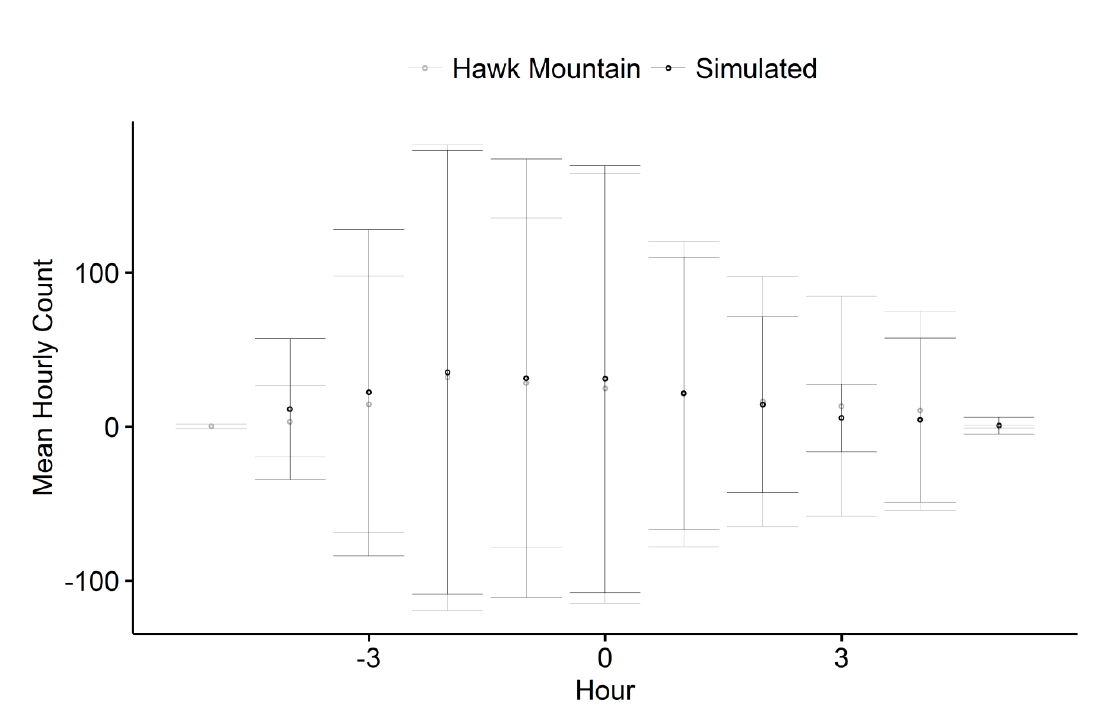
Figure A3.6. Comparison of mean (SD) raptor migration count by hour of the day between data collected at Hawk Mountain, Pennsylvania (1966-2010) and simulated data (20 years), for a species that typically has highly overdispersed counts (Broad-winged